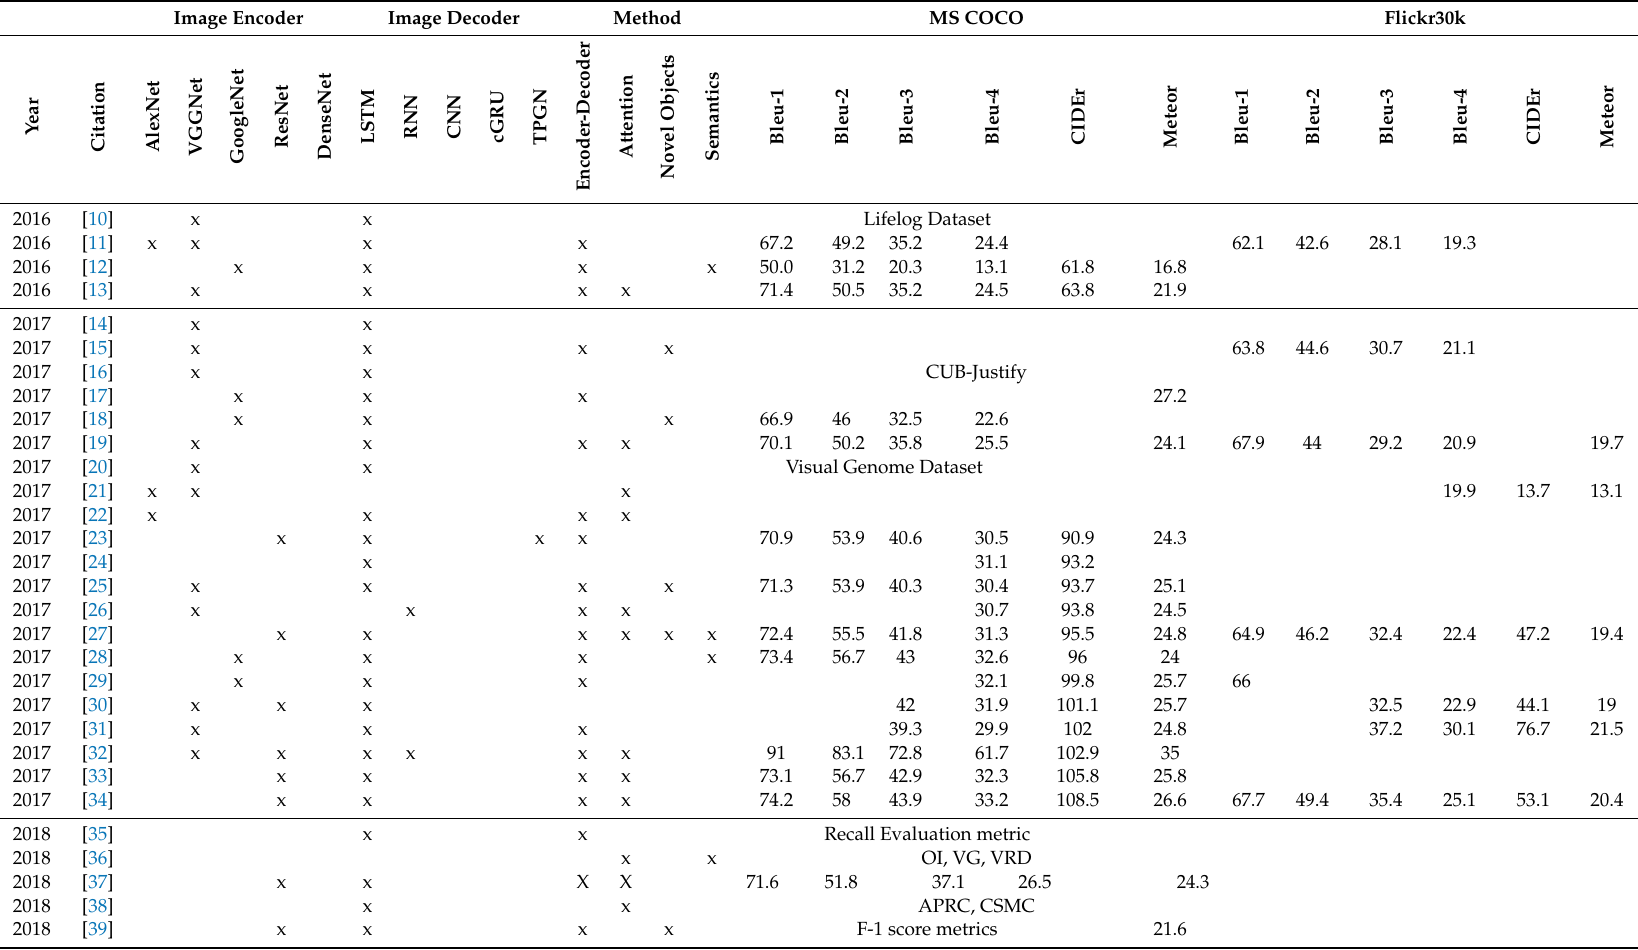
Table A1. Comprehensive comparison table of all articles from the